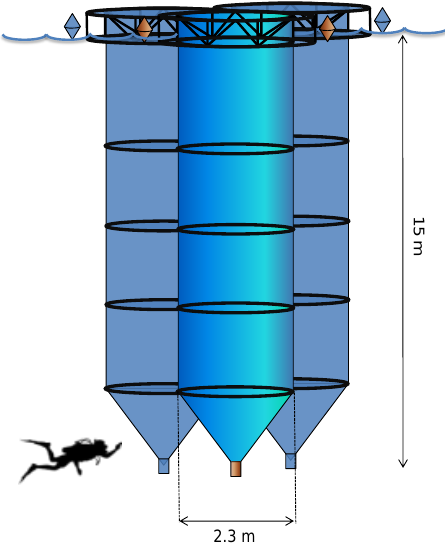
Figure 1. Drawing representing the main features of the large- volume mesocosm device.